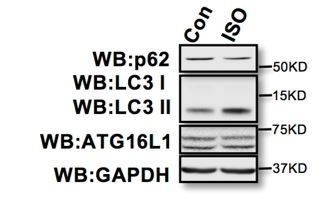
HUVECs treated with PBS(control) and 10 µM isopropanol were lysed in RIPA buffer and proteins were analyzed by western blot using indicated antibodies.